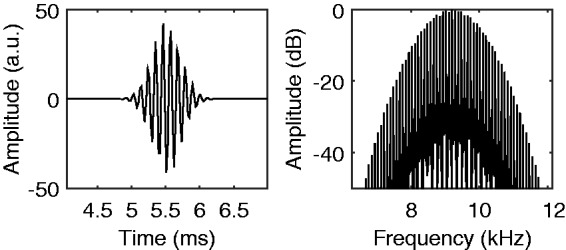
Acoustic pulsatile stimuli used with the NH participants. A single acoustic pulse (left panel) and spectrum of an acoustic pulse train (right panel). The stimuli had a 9200-Hz center frequency and a rate of 90 Hz.